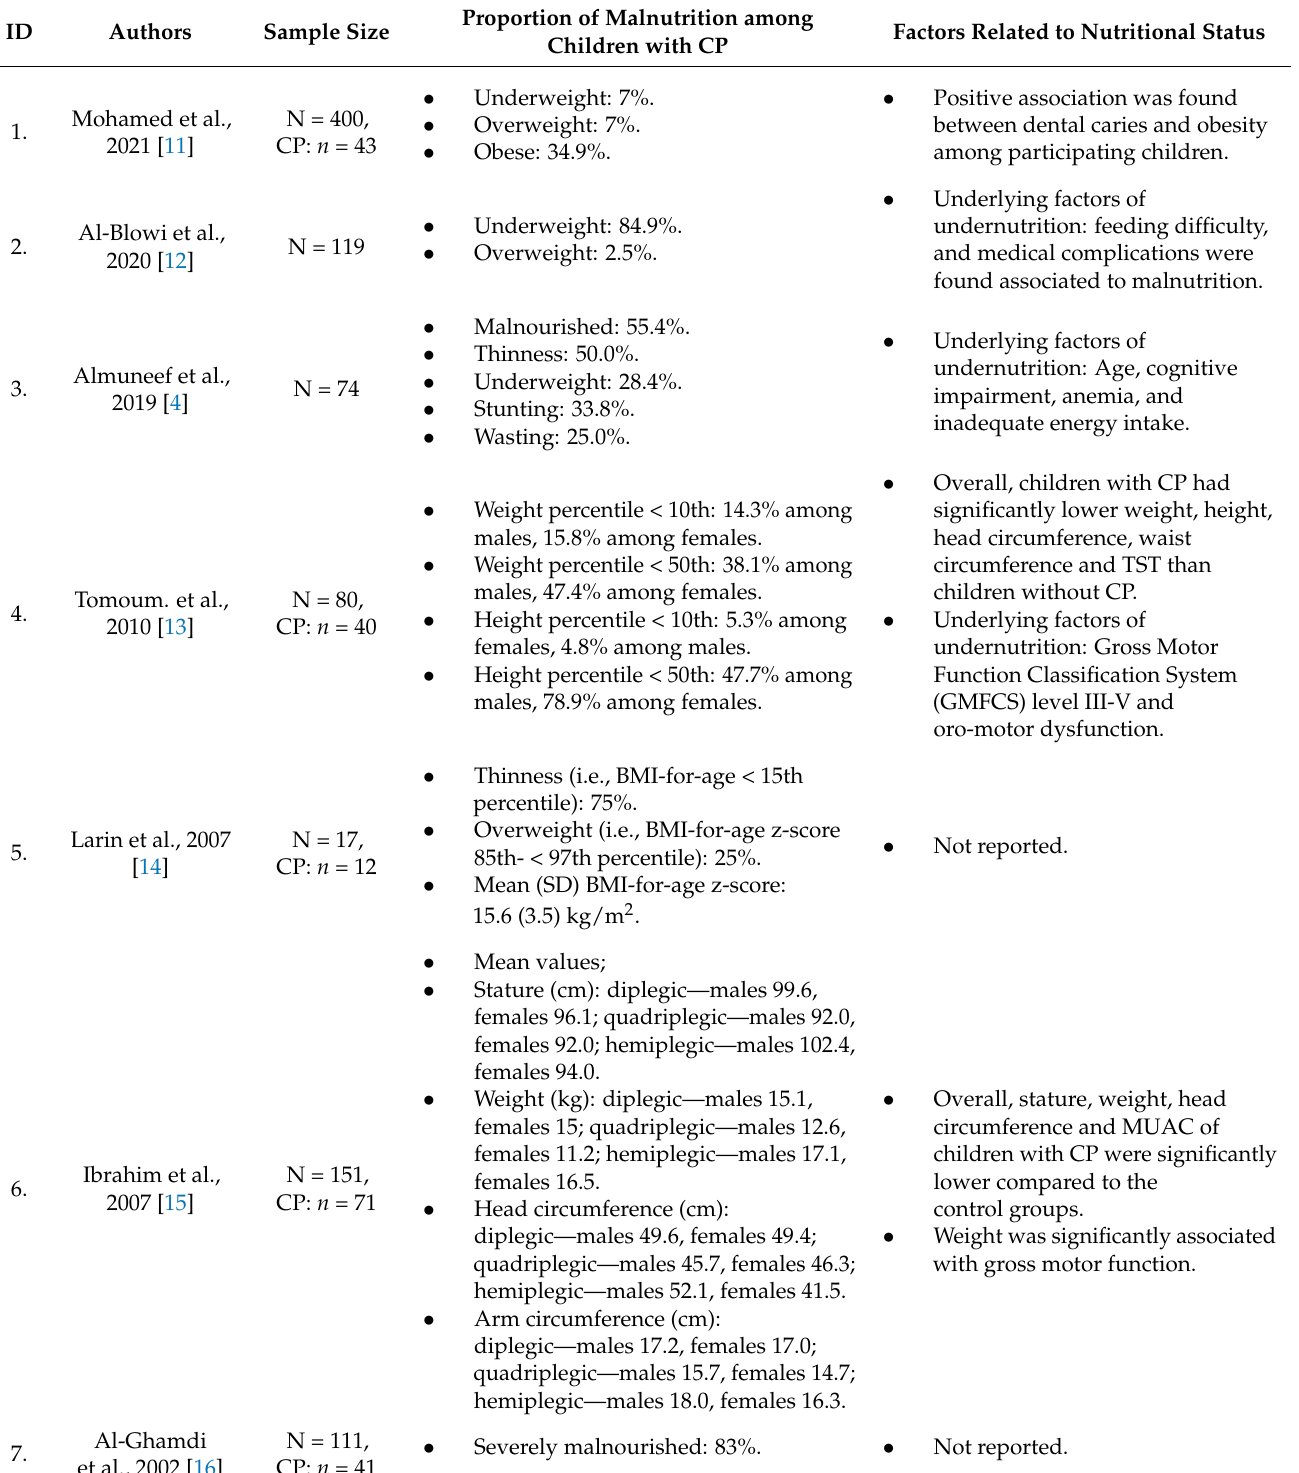
Table 5. Key findings of the included